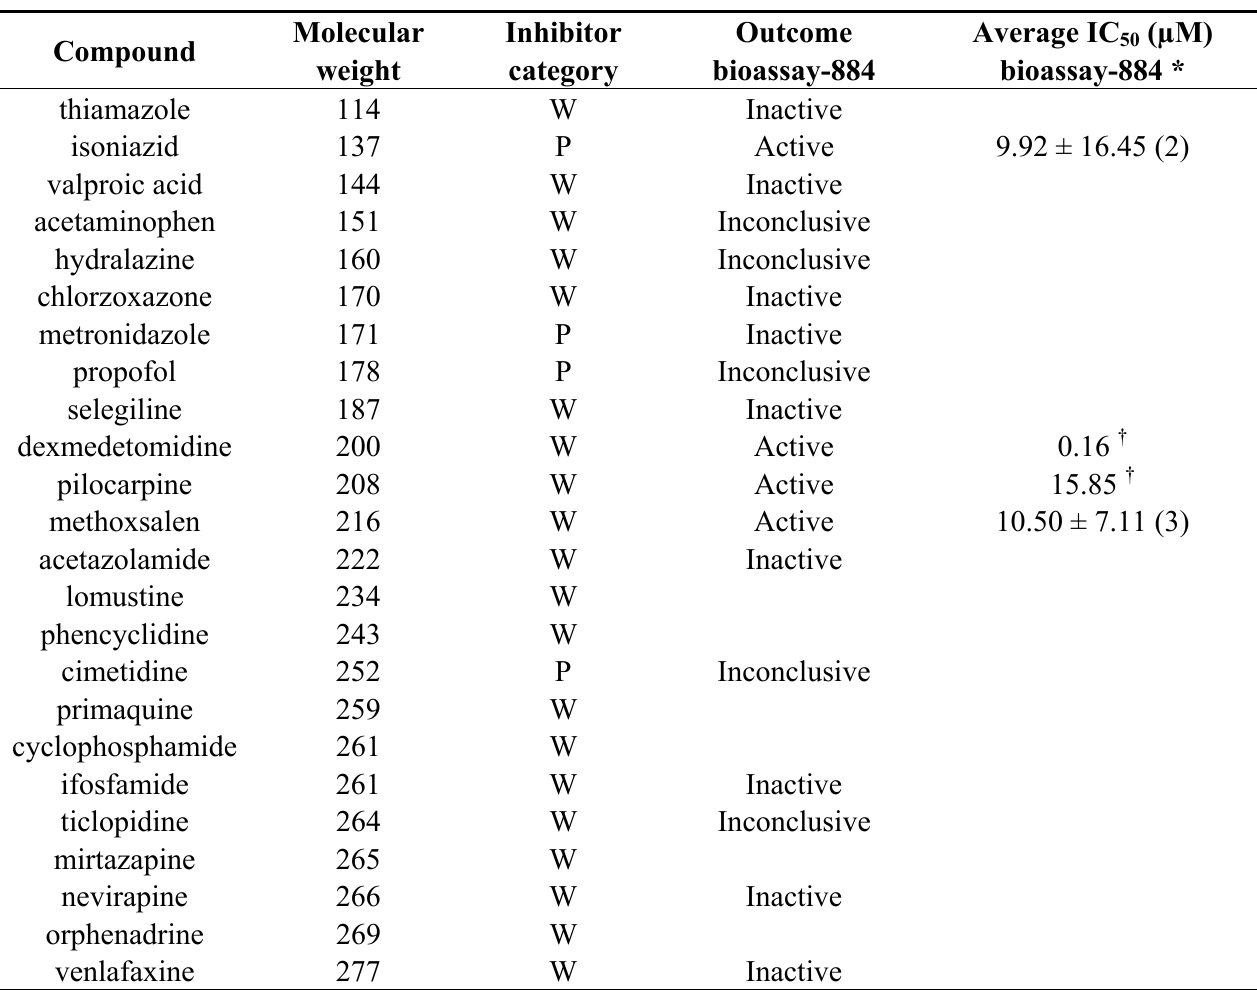
Table 7. Training set of potent (P) and weak (W) inhibitors of CYP3A4 in the low-MW